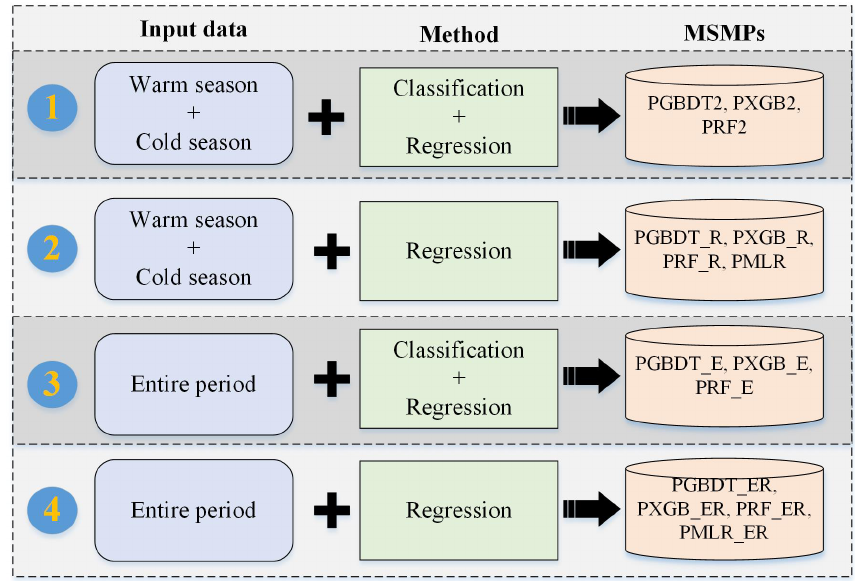
Figure 10. Four scenarios with different sample periods and different models.